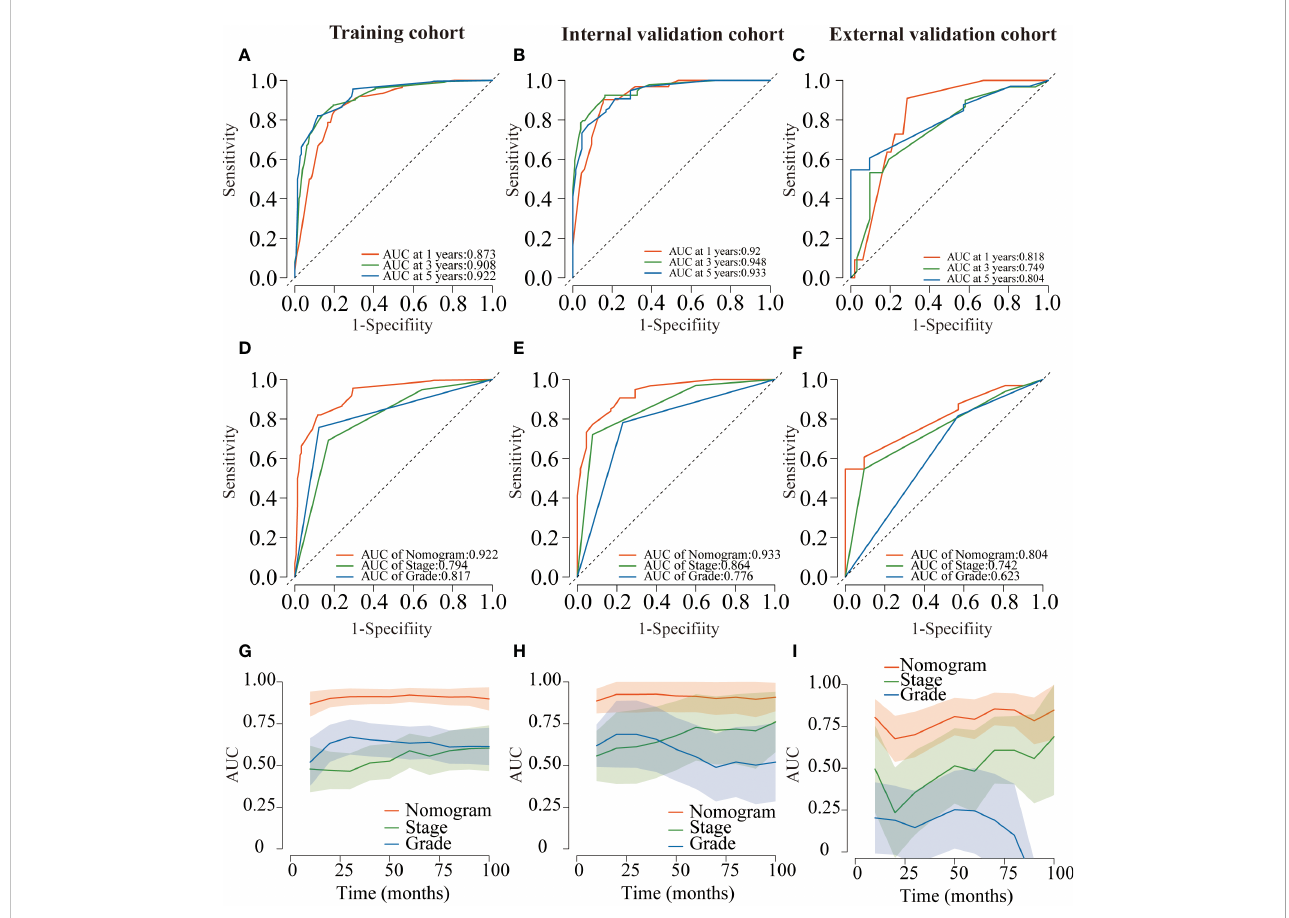
FIGURE 7 ROC curves for the nomogram of CRNENs for 1, 3, and 5-year OS rates in the training cohort (A) , the internal validation cohort (B) , and the external validation cohort (C) . Variable-dependent ROC curves of CRNENs of 5-year OS in the training cohort (D) , the internal validation cohort (E) , and the external validation cohort (F) . Time-dependent AUC curves for the nomogram of OS in the training cohort (G) , the internal validation cohort (H) , and the external validation cohort (I) . CRNENs, colorectal neuroendocrine neoplasms; OS, overall survival. ROC, receiver operating characteristic; AUC, area under the